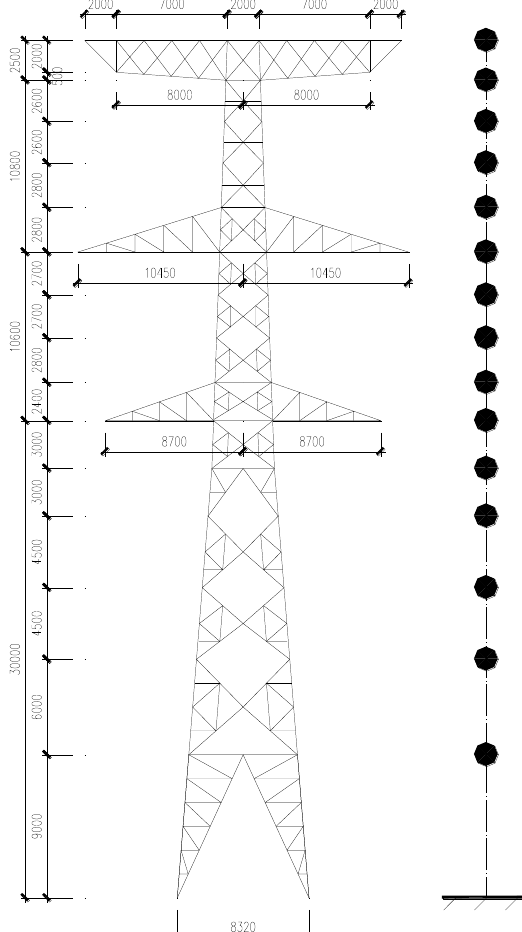
Figure 8. Schematic of the transmission tower.